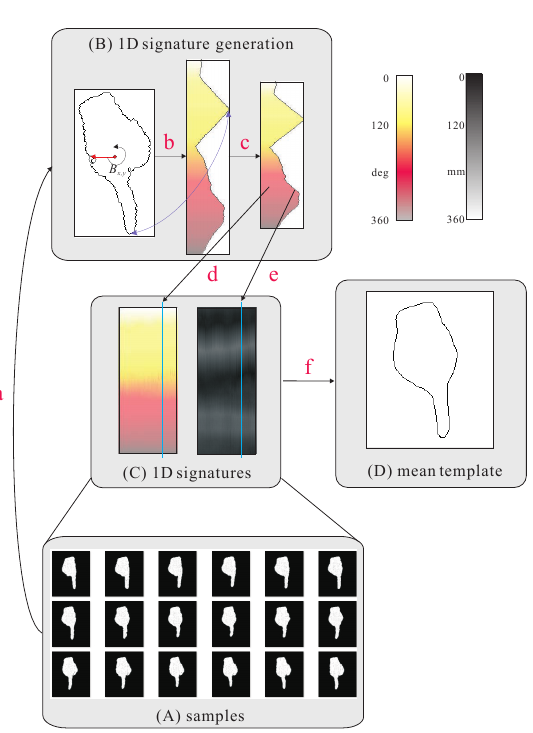
Figure 5: Mean template generation.